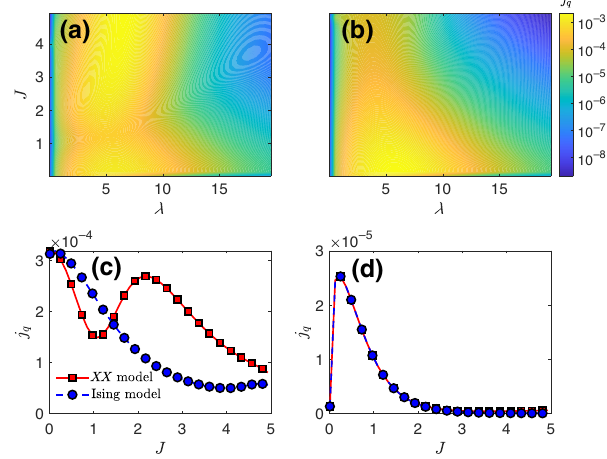
= (cid:11) = 1, T = T = 0.5, and L R L R